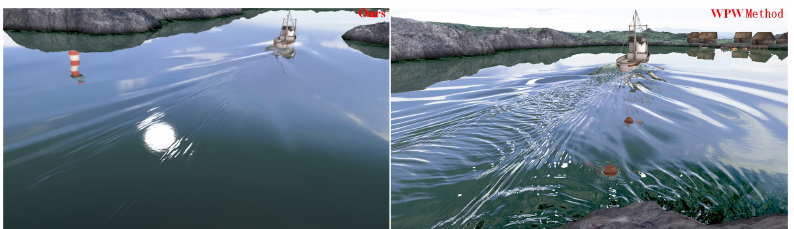
Figure 12. Effect of interaction between a moving ship and the sea surface using our method (L) and the WPW [21] method (R).